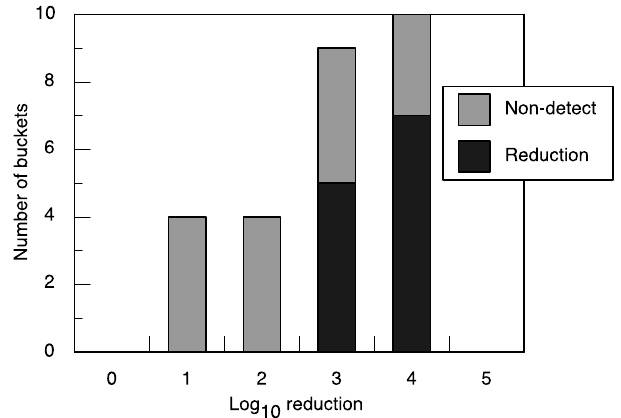
Figure 5. Histogram of the reduction of total coliform bacteria in the buckets at the primary school in community A and laboratory tests of low-turbidity water ( n = 27). Reduction was calculated with the amount of bacteria in the treated bucket or the detection limit if no bacteria was detected. Of the 27 buckets, 15 had no coliform detected (gray); therefore, these buckets potentially represent the detection limit in place of the end bacterial count). The remaining 16 buckets had some bacteria remaining and better indicate the potential disinfection